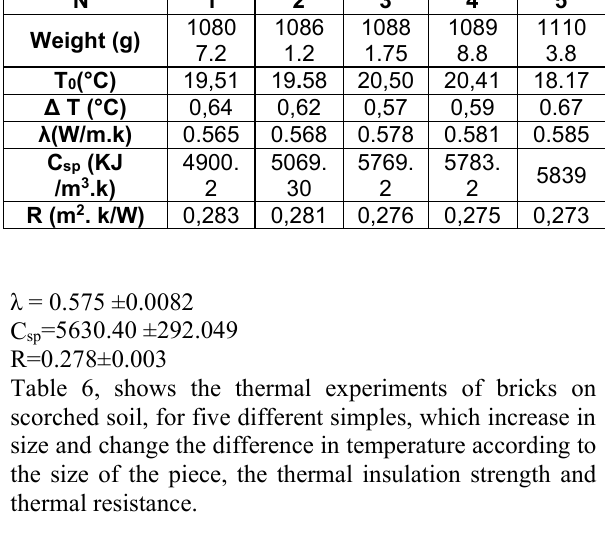
Table 7. Results of the ultrasound velocity calculation for polyester building